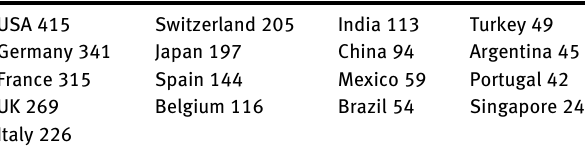
Table  : Weizmann Scientists ’ collaborations by